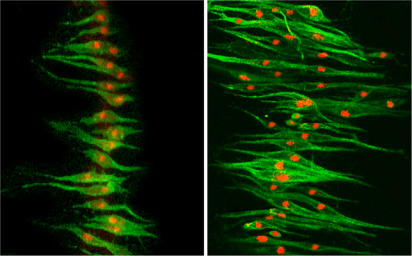

Drosophila adult muscle founder cells are selected by the Heartless signaling pathway. Overexpression of components of the Heartless pathway increases the number of founder cells (right) compared to normal expression (left)